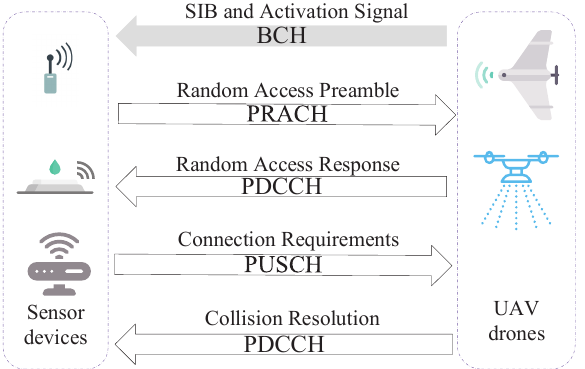
Figure 3. Random access procedure under a cellular